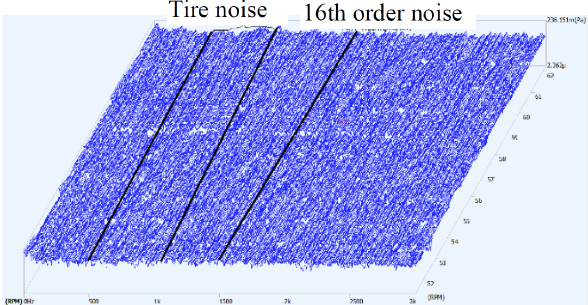
Fig. 3. Noise waterfall array analysis on the right side of Road (Acceleration condition).